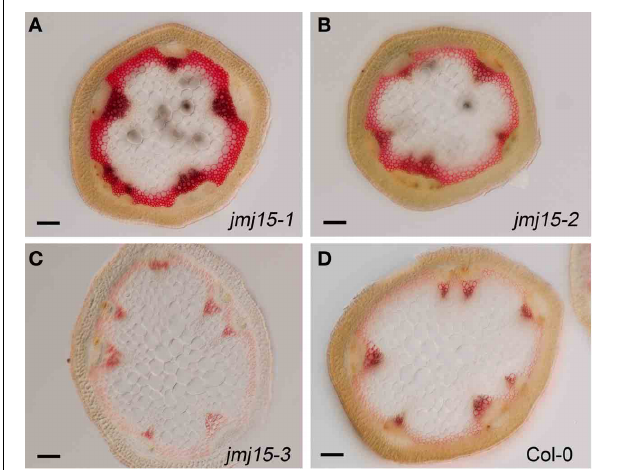
FIGURE 4 | Lignin accumulation in jmj15-1 , jmj15-2 , and jmj15-3 mutants compared to wild type. Sections of the basal part of the inflorescence stem of 5 week-old plants (grown in long day in greenhouse) were stained with phloroglucinol and examined by light microscopy. Phloroglucinol reacts with coniferaldehyde groups in lignin, and the color intensity reflects the total lignin content. Bar =